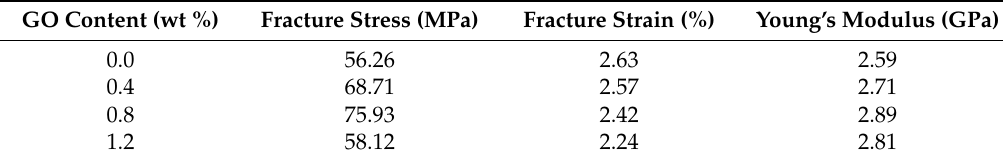
Table 1. Tensile parameters of nanocomposites with various GO